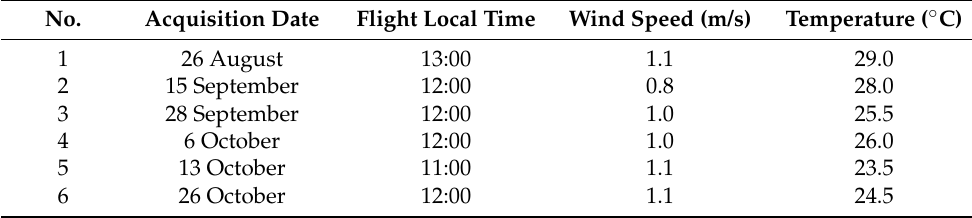
Table 2. Description of flight characteristics for image acquisition.